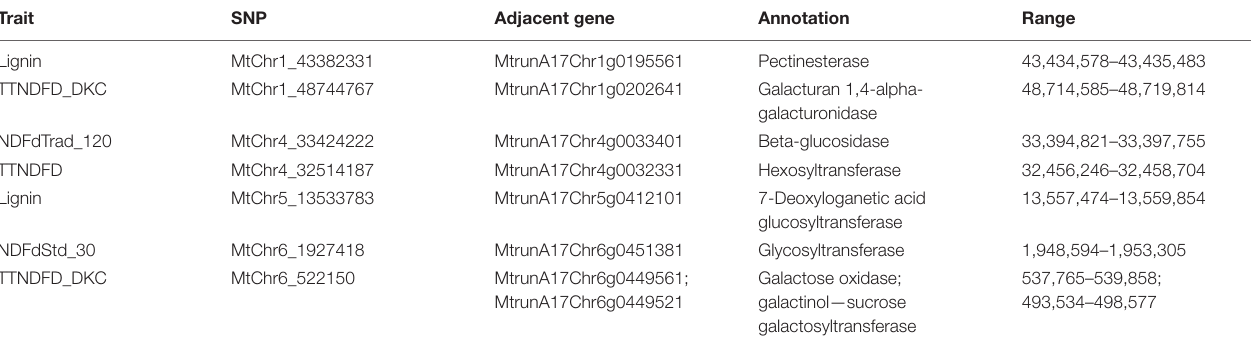
TABLE 3 | Potential candidate genes within 50-kb of significant